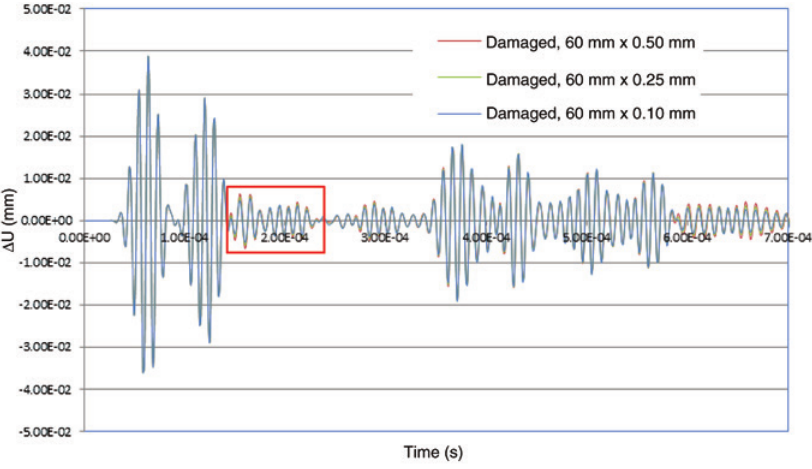
Figure 16: Comparison of wave responses of different delamination thicknesses.